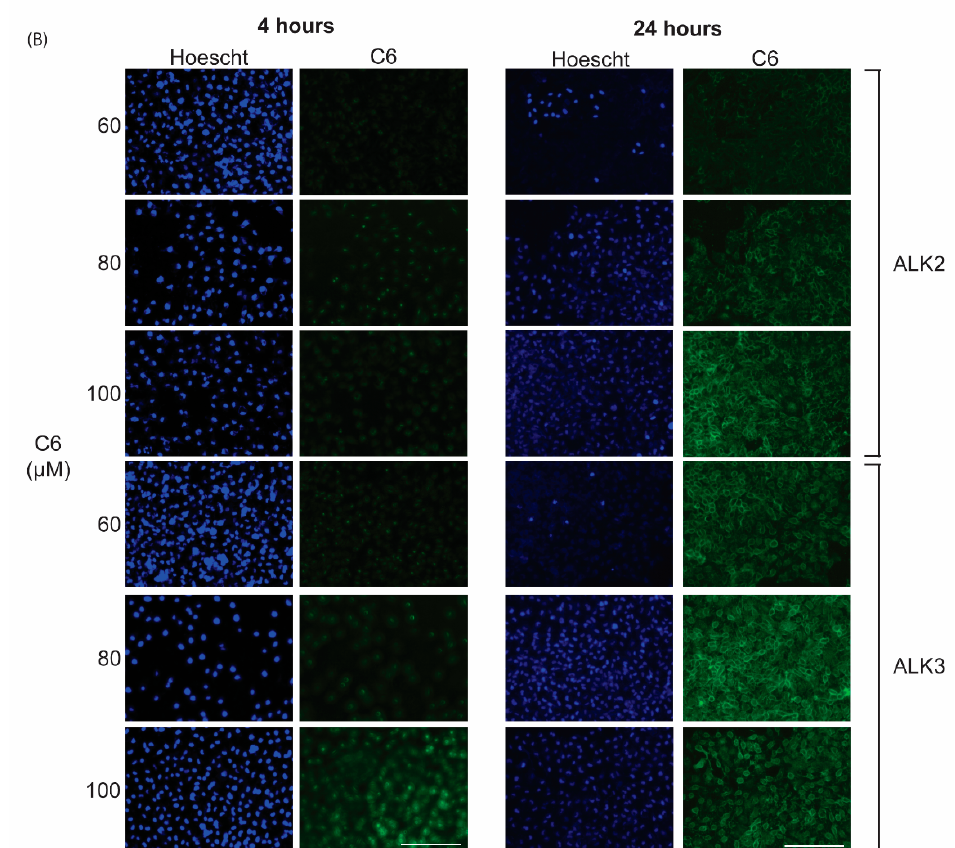
Figure 10. Peptides were mixed with 60, 80, or 100 μ M C6 and then prepared using film dehydration and rehydrated in water. Peptide assemblies were incubated with cells for 4 or 24 h, followed by evaluation of cellular uptake using ( A ) flow cytometry and ( B ) fluorescent microscopy. Untreated cells were used as a negative control (NC), and 100 μ M of C6 was used as a positive control (PC). Results are presented as mean ± SEM (N = 3), where * p < 0.05, ** p < 0.01, and *** p < 0.001 compared to NC (one ‐ way ANOVA). Scale bar = 200 μ m.